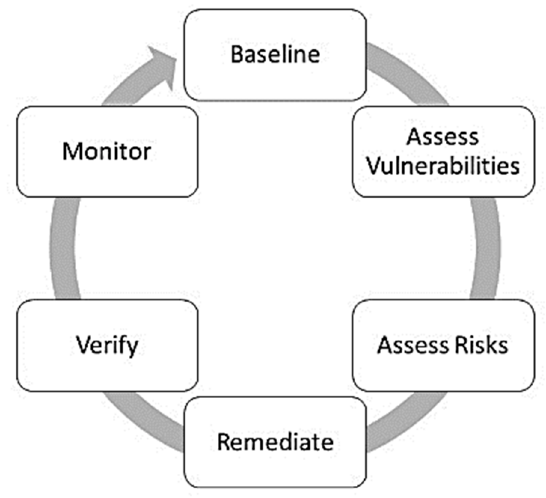
Figure 2. Vulnerability management life cycle.